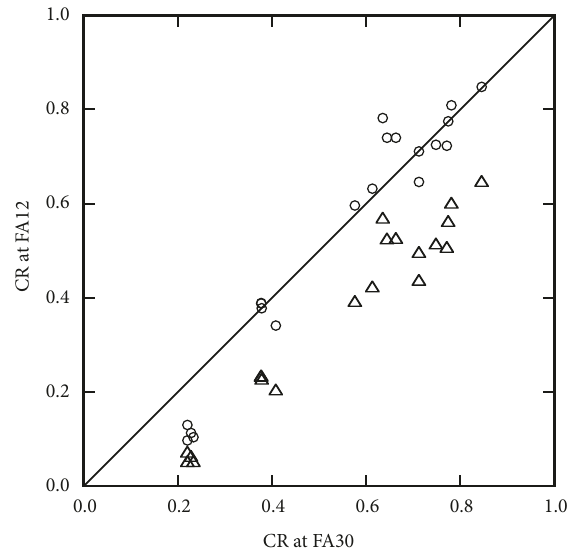
Figure 4: Relationship between CRs determined at FAs of 30 ∘